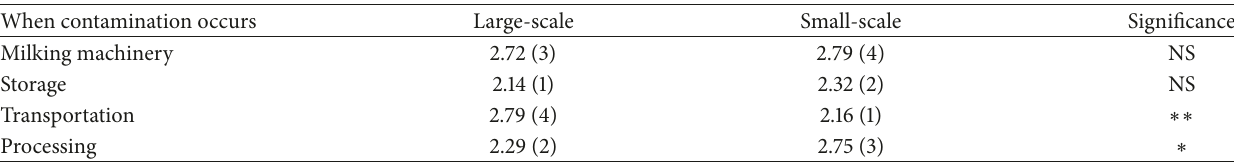
Table 4: Mean rank score (ranks) for sources of contamination postmilking in commercial and small-scale dairy farms. When contamination occurs